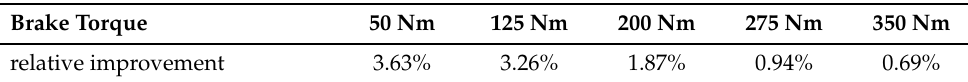
Table 4. Comparison of the concepts in terms of brake efficiency in the relevant load range for the driving